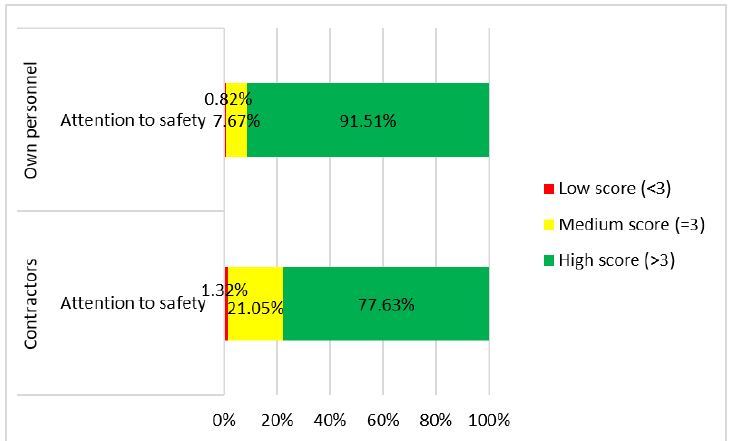
Figure 15. BARS averages by contractual relationship.